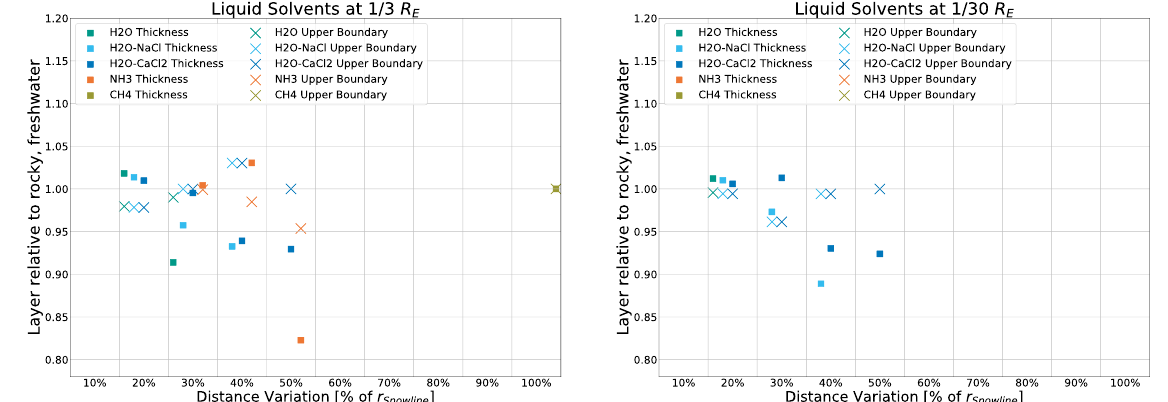
Figure A4. Deviation from the rocky, freshwater model for liquid layer thickness and upper boundary for a rocky crust with CaCl 2 -saltwater inclusions.